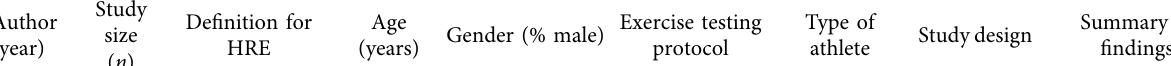
Table 2: Study characteristics of included studies with